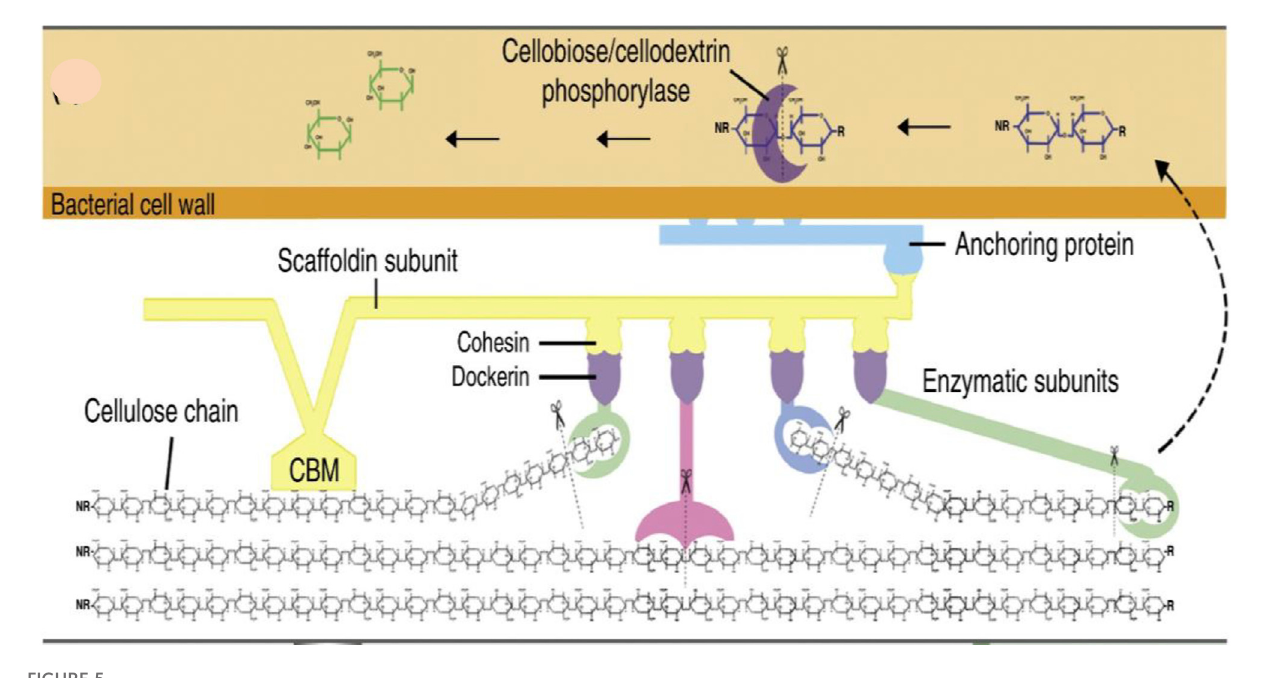
FIGURE 5 This diagram represents the cellular mechanism of lignocellulose degradation in the bacterial cell wall. Anaerobic degradation of lignocellulose is performed by a cellulosome complex which is attached to the cell wall of bacteria via an anchoring subunit. This complex consists of enzymes that are responsible for the hydrolysis of cellulose are and attached to a scaffolding subunit that anchors the enzymes and bacterial cells to the substrate by a carbohydrate-binding module (CBM) (Cragg et al.,